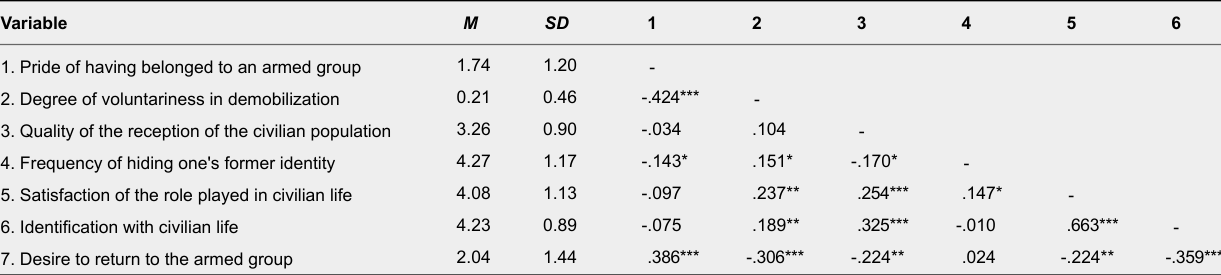
Means, Standard Deviations Pearson’s Correlations Between the Main